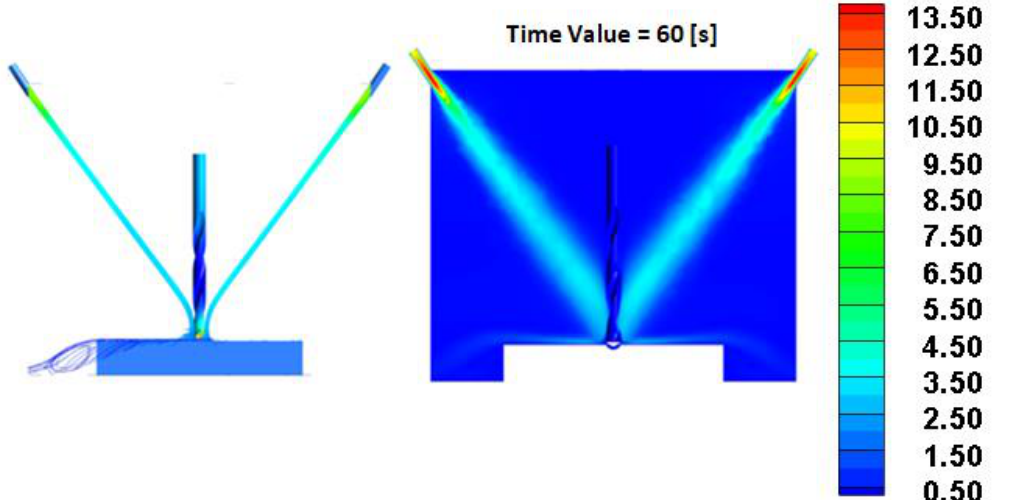
Figure 5. Velocity streamlines and velocity distributions in the machining